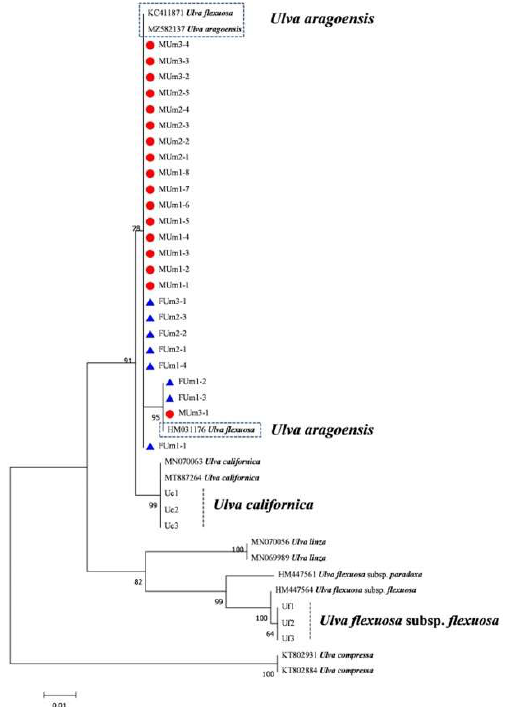
Figure 9. Maximum likelihood tree constructed from the analysis of 18S gene sequences of U. aragoensis samples and those downloaded from GenBank.